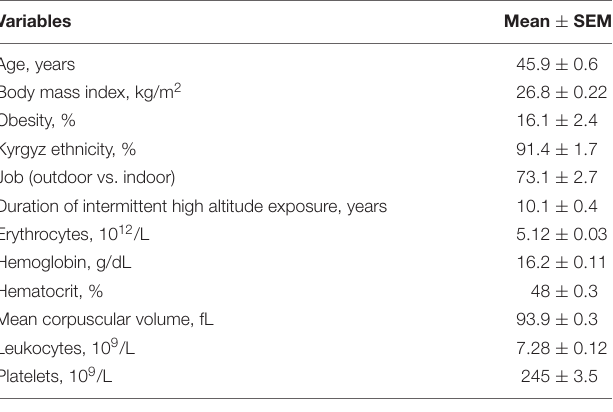
TABLE 1 | Anthropometric hematological characteristics of the subjects ( n = 266).